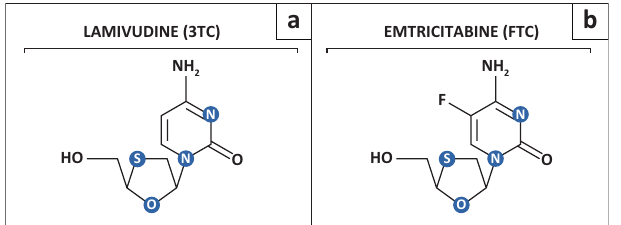
FIGURE 1: The chemical structure of (a) lamivudine and (b)